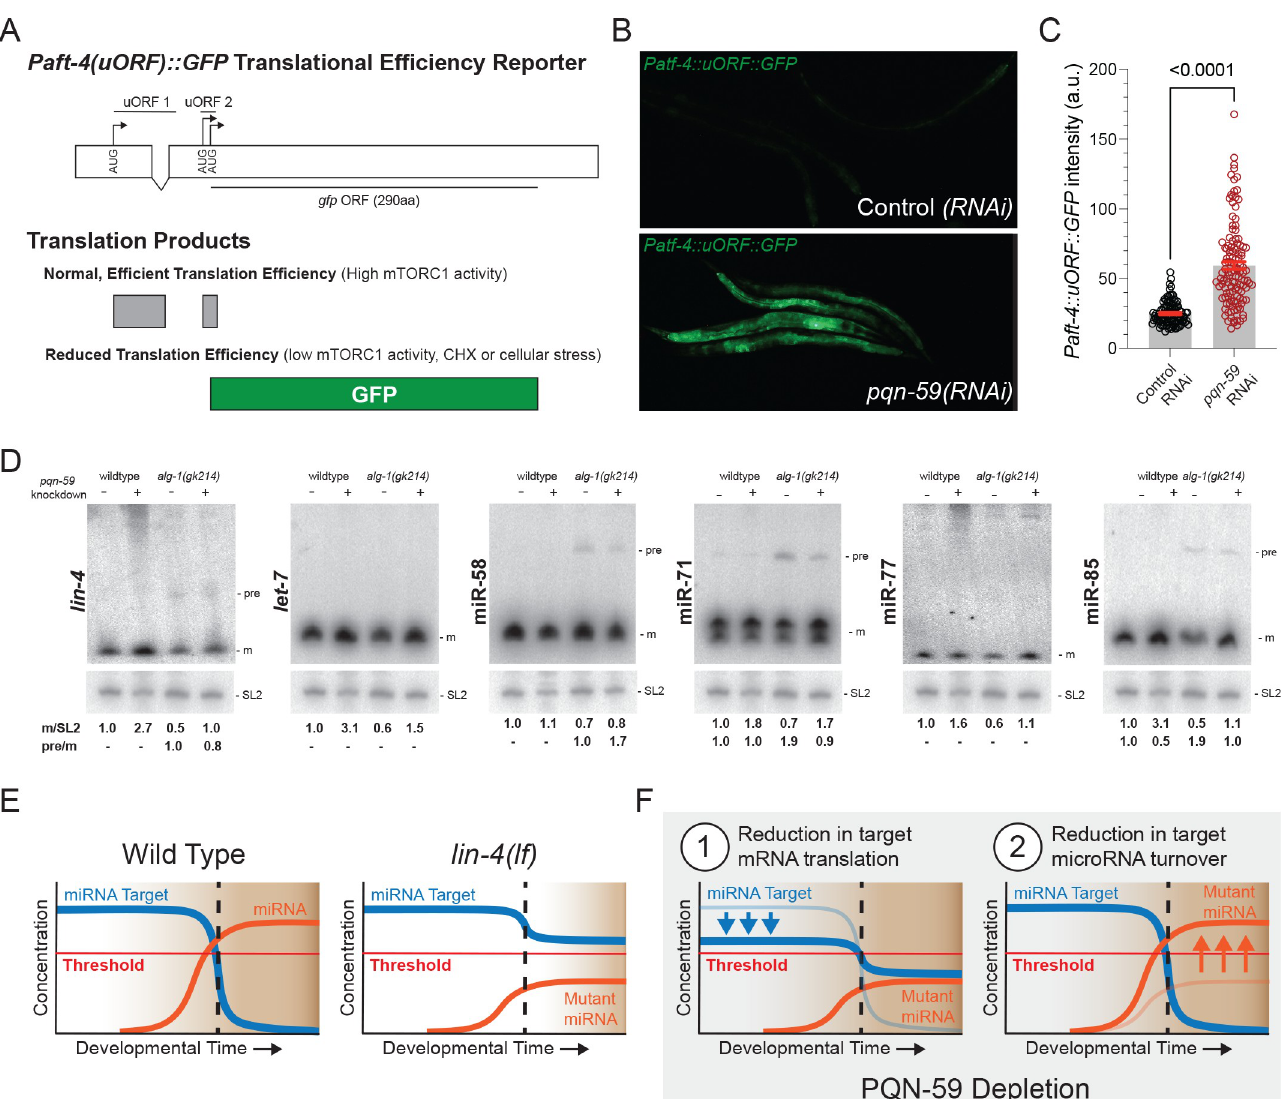
Fig 7. Depletion of pqn-59 by RNAi alters translation and miRNA metabolism. (A) Knockdown of pqn-59 leads to preferential translation of P atf-4 (uORF):: GFP reporter. Under normal conditions where translational initiation efficiency is high, the two uORF in the 5’UTR of the atf-4 mRNA are translated. Because the translational register of the second uORF is in a different reading frame and overlapping with the atf-4 ORF, GFP expression is dramatically reduced. Upon reduction of global protein translation, translational initiation of the uORFs in the 5’UTR of the atf-4 mRNA transcript is inefficient enabling an increased initiation of the atf-4 ORF and increased GFP fluorescence in transgenic animals. (B and C) L4 or day-1 adult animals were placed on RNAi and GFP fluorescence was measured at the L4 of the offspring. Shown are three independent biological trials. Data is represented as mean + SEM. Dots represent individual animals (N > 100). P-value was determined using an unpaired t -test two-tailed. (D) miRNA northern analysis of total RNA extracted from staged, wild-type and alg-1(0) , alg-1(gk214) , mutant animals. Animals were exposed to control or pqn-59 dsRNAs from hatching to the late L4 stage of larval development prior to RNA extraction. For calculation of relative expression of mature miRNA species, each experimental condition was calibrated to the expression level of 20 μ g of total RNA derived from wild-type animals exposed to control dsRNA. SL2 RNA levels were used as an input control. Pre-miRNA to mature RNA was calculated relative to the ratio of the signal in indicated sample. (E) Model of the generic bi-stable switch that incorporates a miRNA to control temporal cell fates during development. Normally (left side), the miRNA target gene is expressed above a critical threshold early in development and is responsible for enforcing earlier cell fate identities. At a defined point in development, the induced expression and activity of a miRNA gene rapidly curtails the target expression below a critical threshold enabling a clear change in cell fate at an important developmental milestone (demarcated by vertical dashed line). In miRNA mutants that under- accumulate functional miRNAs (e.g., lin-4(ma161) ), the expression and activity of a mutant miRNA lowers the expression of the target gene but not below the critical threshold to enable a change in the bistable switch. (F) We propose two non-exclusively mutual mechanisms by which depletion of pqn-59 may suppress the defects associated with ineffective miRNA-mediated gene regulation in bistable developmental switches. In Model 1, depletion of pqn-59 may increase the stability of the mutant miRNAs enabling the target gene to be efficiently dampened below the threshold at the developmental milestone. This model is consistent with data shown in above in panel A. Alternatively (Model 2), PQN-59 may function like UBAP2L and stimulate translation of some miRNA target mRNAs. Depletion of pqn-59 would lower the expression of the target gene independent of miRNA expression. This reduced expression would bring miRNA target